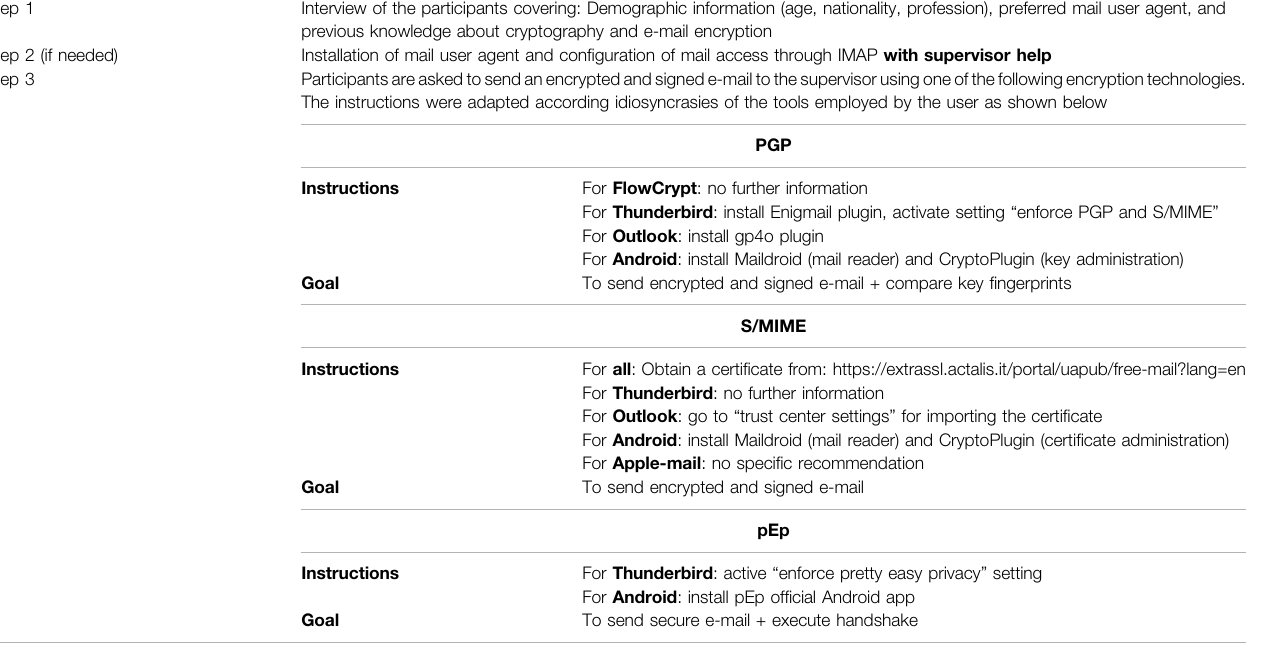
TABLE 3 | Testing protocol. Step